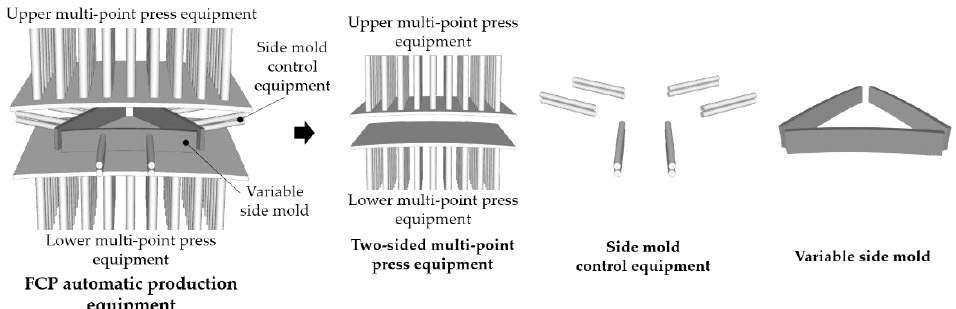
Figure 1. Configuration of FCP automatic production equipment.